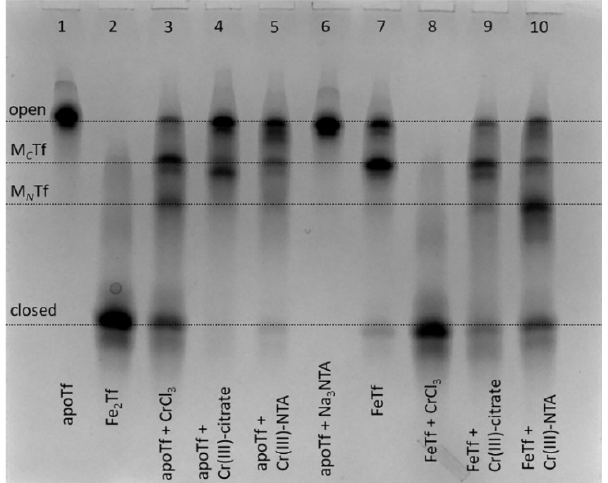
Figure 2. Urea-PAGE of reaction mixtures containing 30 μM apoTf or FeTf and 150 μM of Cr(III) complexes (aquated CrCl 3 , Cr(III)-citrate or Cr(III)-NTA, see Materials and Methods for details) in the binding buffer (20 mM HEPES, 25 mM NaHCO 3 , 140 mM NaCl, pH 7.4) [3] after 24 h of reaction at 310 K. Lanes 1, 2, 6 and 7 contain control samples without Cr(III). All samples were diluted to ~5 μM Tf with the binding buffer before loading into the gel. Four main Tf conformations (Figure 1) are marked (M C Tf and M N Tf contain one metal ion bound to C -lobes or N -lobes, respectively).